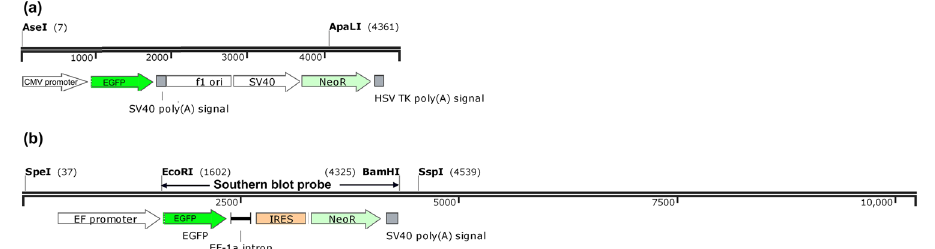
Figure 5. Schematic structure of linearized plasmids. ( a ) Structure of pEGFP-N1. ( b ) Structure of pEGFP- IRES-Neo, approximate positions of the Southern blot probe and restriction enzyme sites are illustrated. The drawing is not to